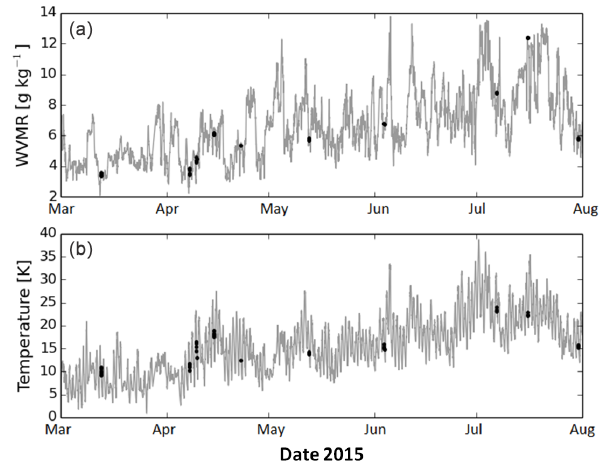
Figure 8. Time series of WVMR (a) and temperature (b) measured by a PTU sensor during the Saint-Mandé campaign in 2015. Data are plotted with 5min time resolution. The black dots indicate the nights when the Rameau lidar system was